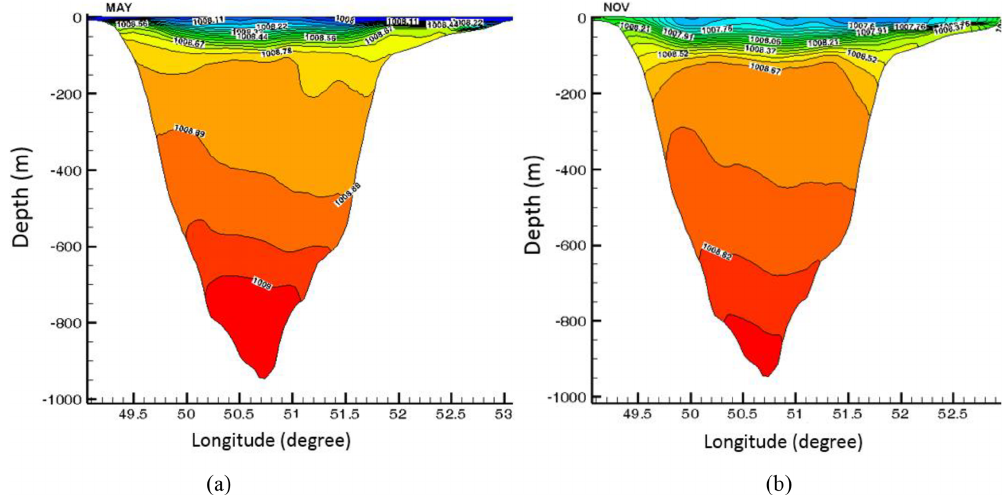
Figure 13. Density fields along transect V (from the numerical model) in May (a) and November (b)